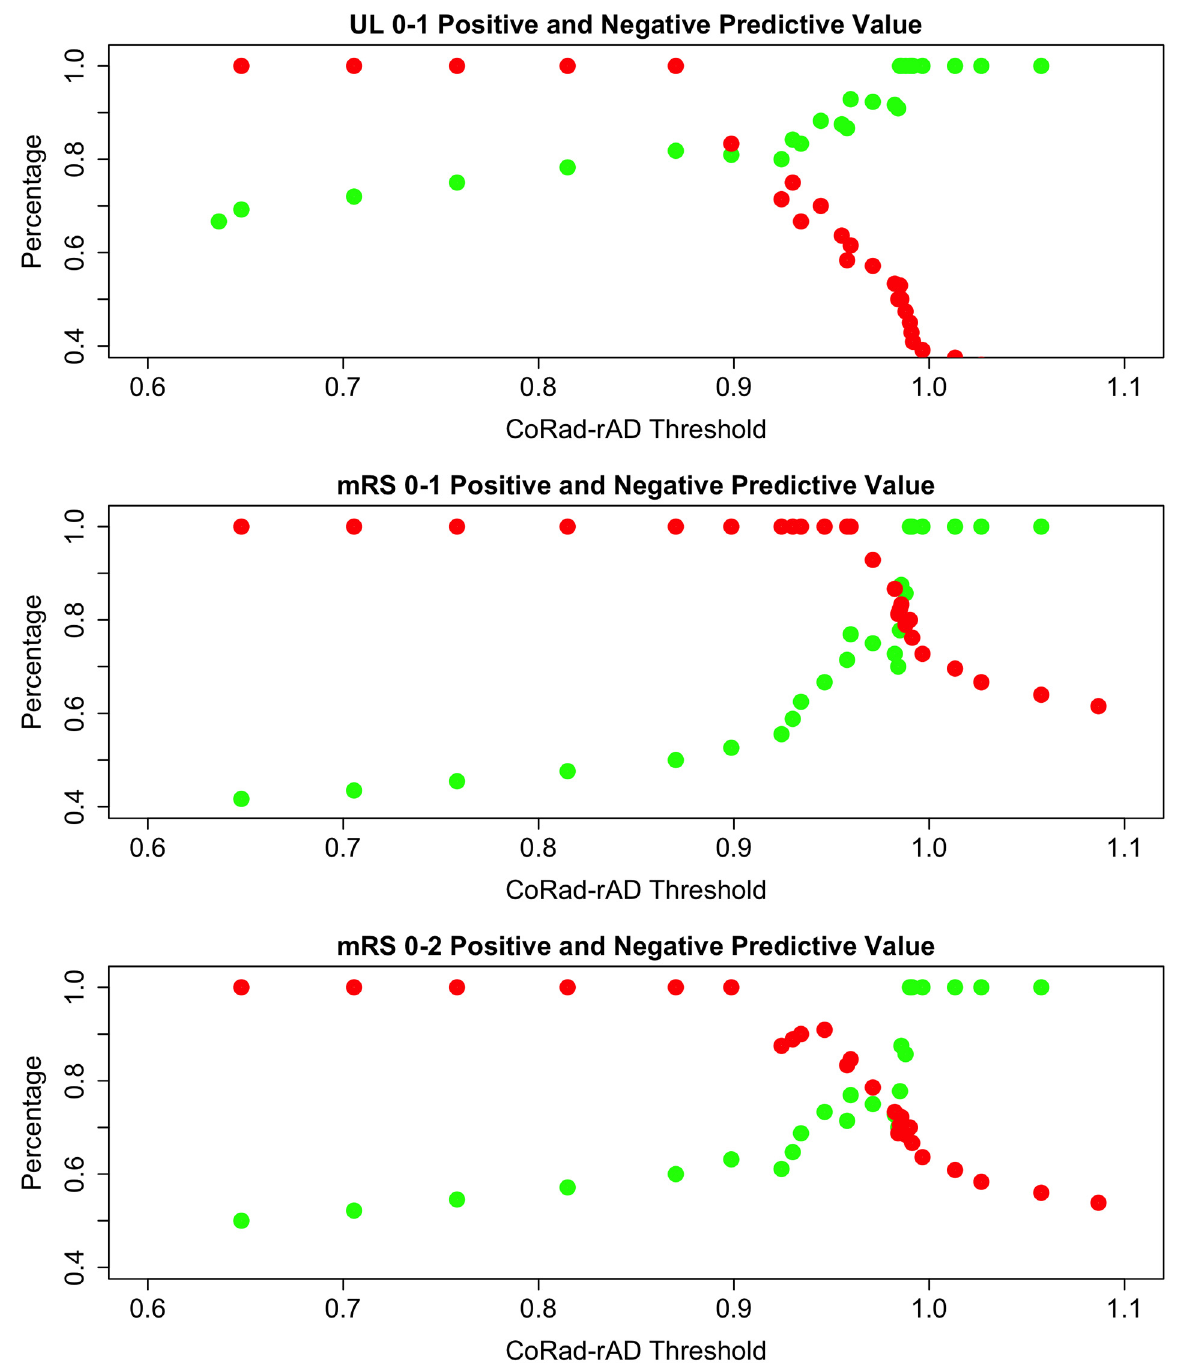
Fig 3. Positive and Negative Predictive Values for good outcome as a function of CoRad-rAD values. The positive predictive values (PPV in green) correspond to the CoRad-rAD values above the threshold (x-axis). The negative predictive values (NPV in red) correspond to the CoRad-rAD values below the threshold. (A) Good outcome is assessed by NIHSS item 5 for upper limb (UL) scores 0 – 1 at day 7 post-stroke. (B) Very good outcome is assessed by mRS (cid:3) 1 at 3 months post-stroke. (C) Good outcome is assessed by mRS (cid:3) 2.